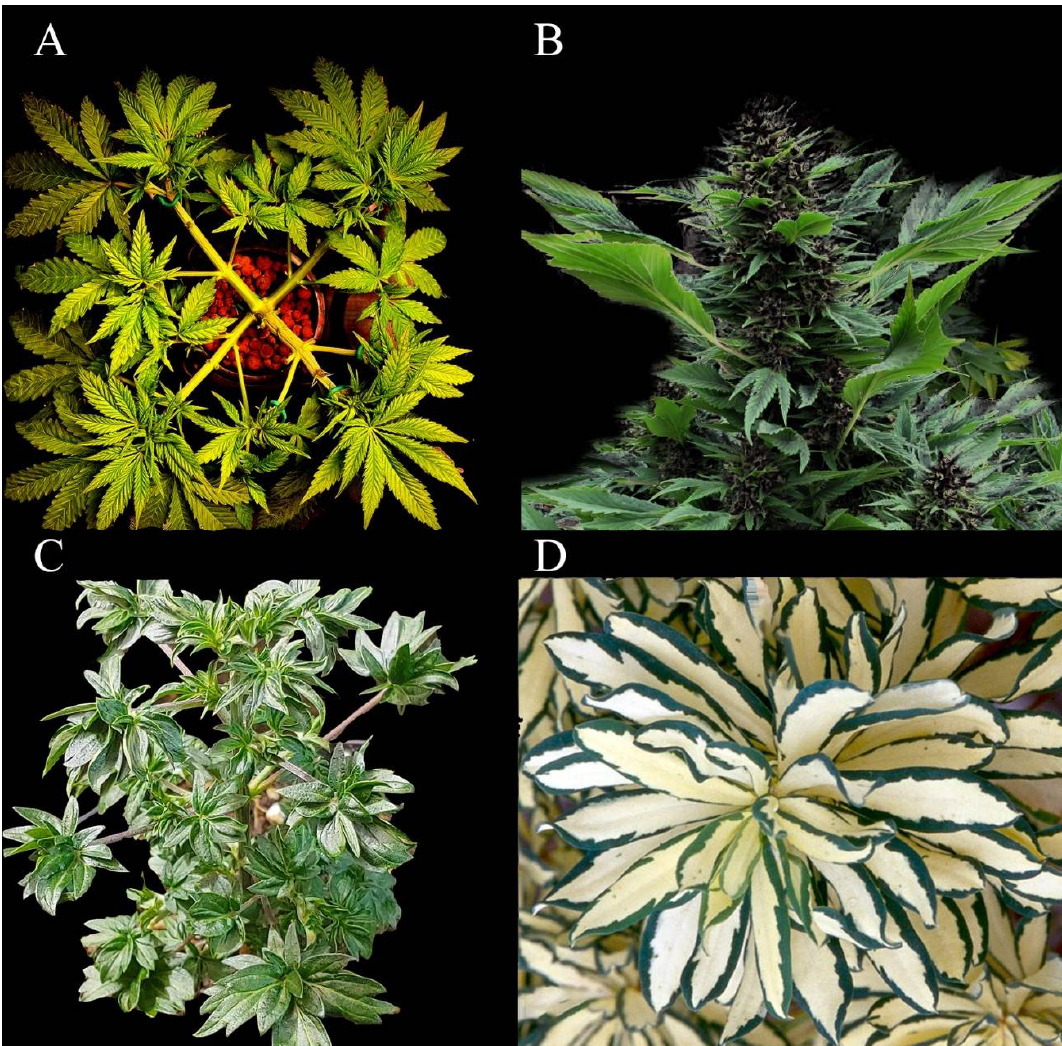
Figure 5. Some examples of cannabis mutants with ornamental value. ( A ) whorled phyllotaxy, ( B ) Ducksfoot, ( C ) Australian Bastard Cannabis, and ( D ) variegated leaves. Image credit: Dutch Pas- sion.